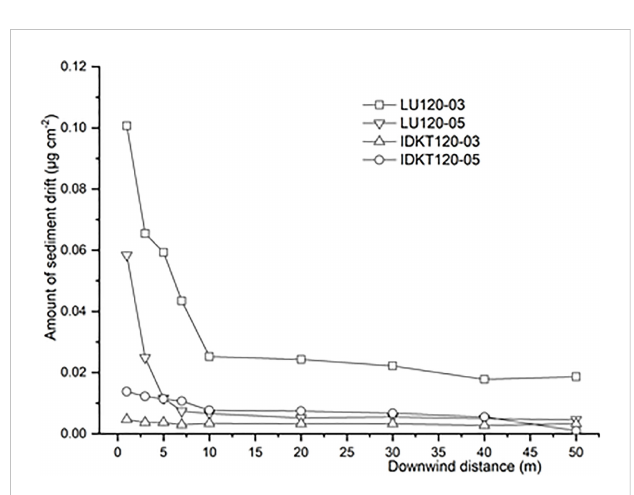
FIGURE 6 Sediment drifts of nozzles in different downwind distances.